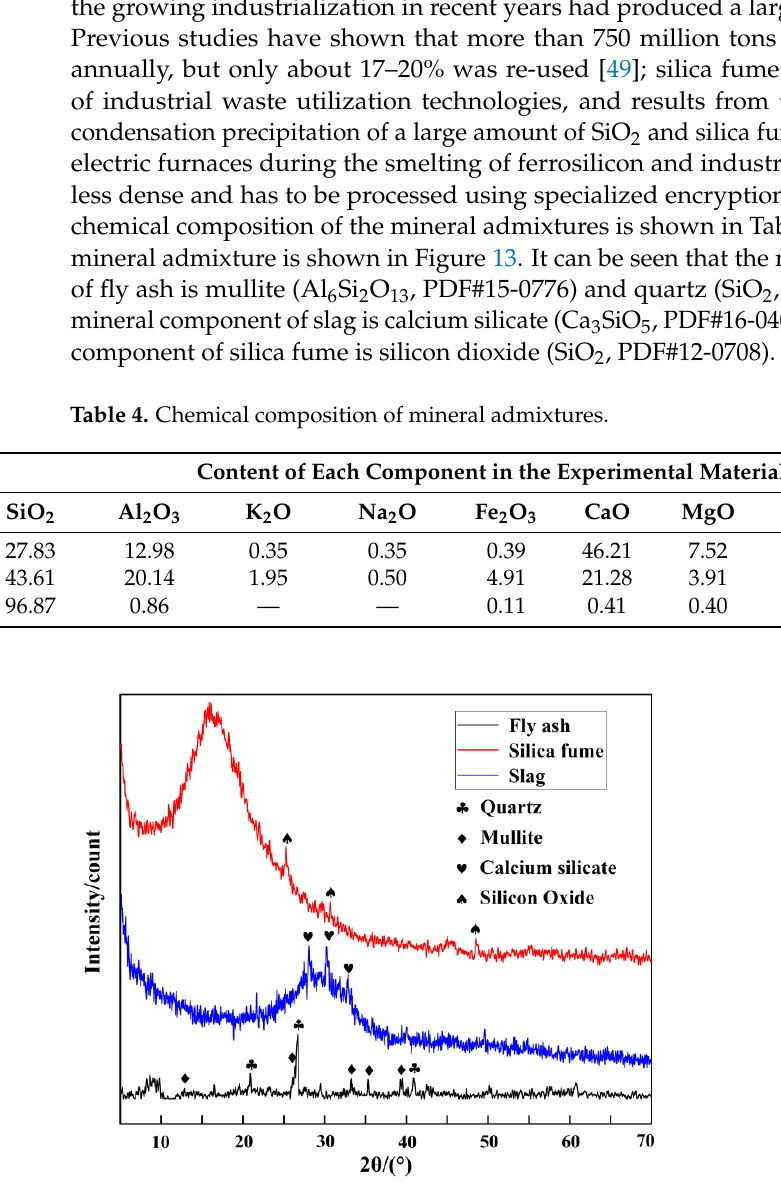
Figure 13. X-ray diffraction pattern of mineral admixture.